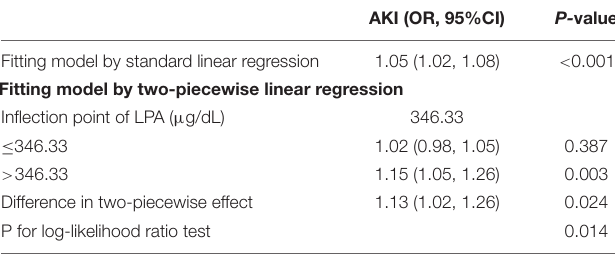
been well described for patients with AAD previously